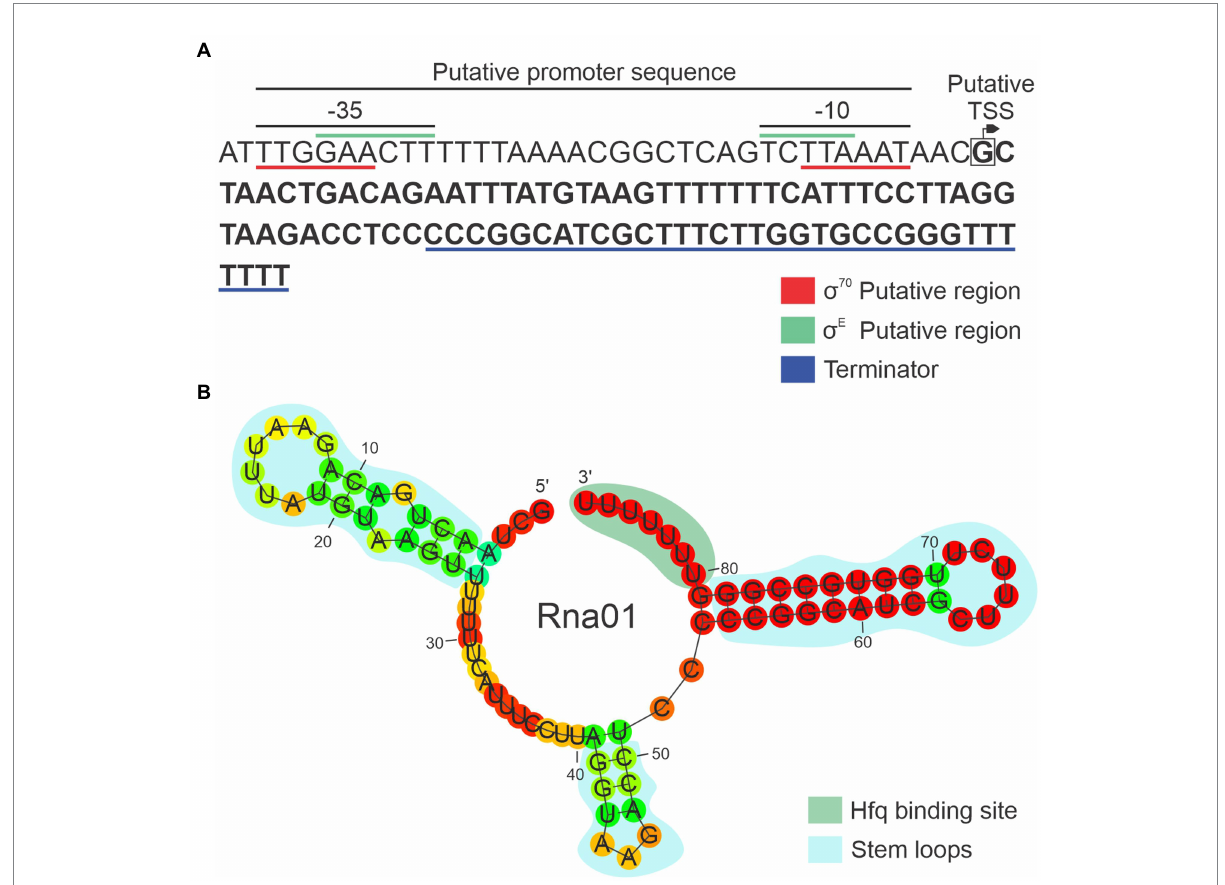
FIGURE 3 Characterization of the new sRNA Rna01. (A) Coding sequence of rna01 . The putative promoter and Rho-independent terminator are shown. The putative transcriptional start site (TSS) is represented by the box with an arrow, and the − 35 and − 10 regions for each putative promoter sequences are underlined. The Rna01 sequence is highlighted in bold. (B) Secondary structure of Rna01 predicted using Rnafold software. The putative stem loops and putative Hfq binding site are